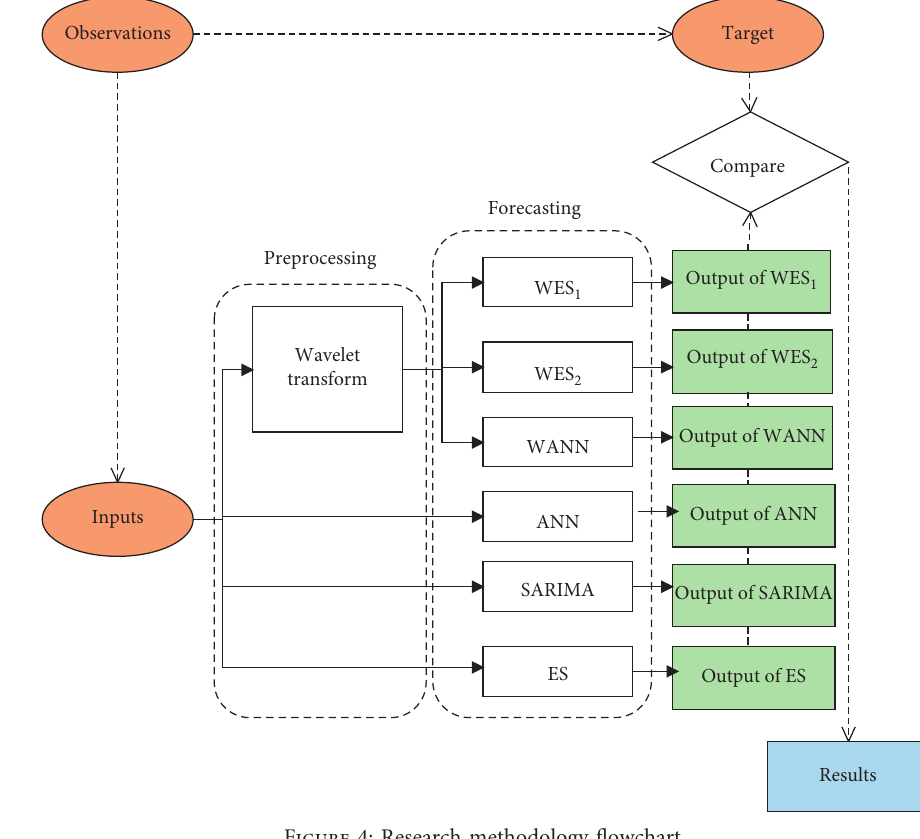
Figure 4: Research methodology flowchart. Table 3: Performance results of the WES